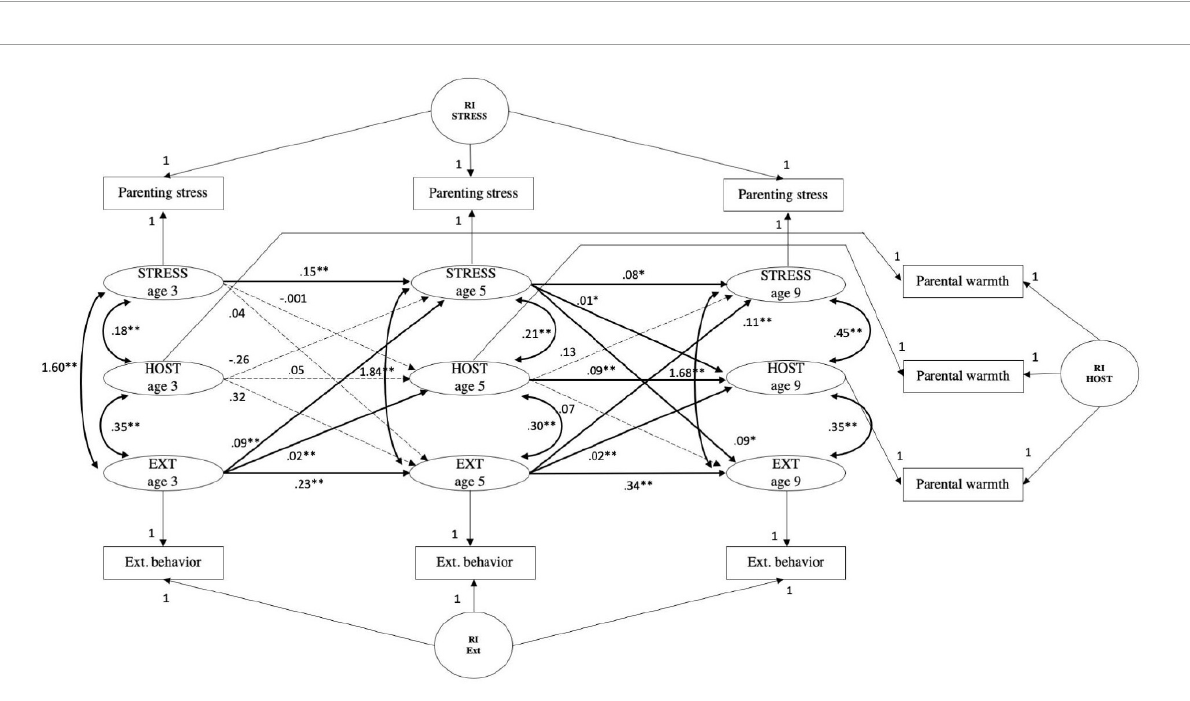
FIGURE6 Random intercepts cross-lagged panel model showing relations among parenting stress (STRESS), parental hostility (HOST) and child externalizing behaviors (EXT) across three waves. Age 3, wave 2; age 5, wave 3; age 9, wave 5; R, residual variance; RI EXT, random intercept child externalizing behavior; RI STRESS, random intercept parenting stress; RI HOST, random intercept parental hostility. Standardized estimates reported. Gray dashed paths indicated non-significant estimates. ∗ p < 0.01, ∗∗ p <